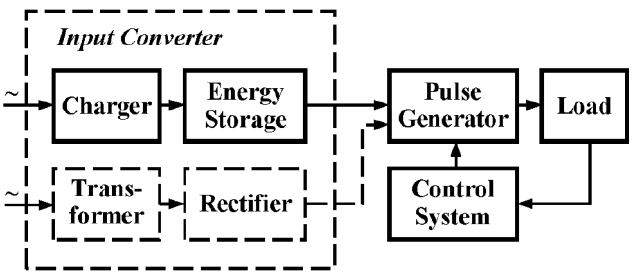
Fig. 1. Generalized block diagram of the power supply for micro resistance welding.